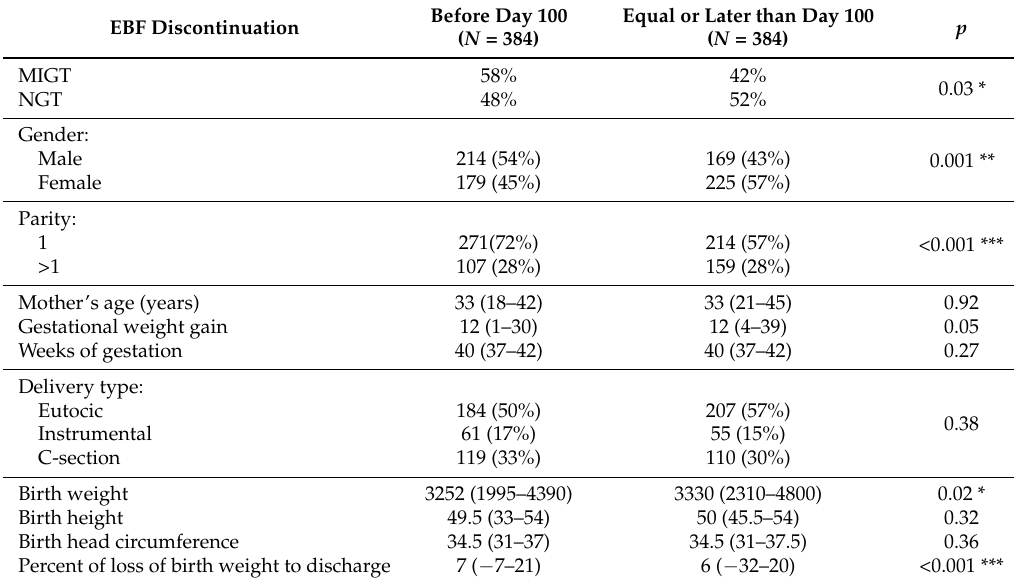
Table 2. Results for univariate analysis of exclusive breastfeeding (EBF) duration.